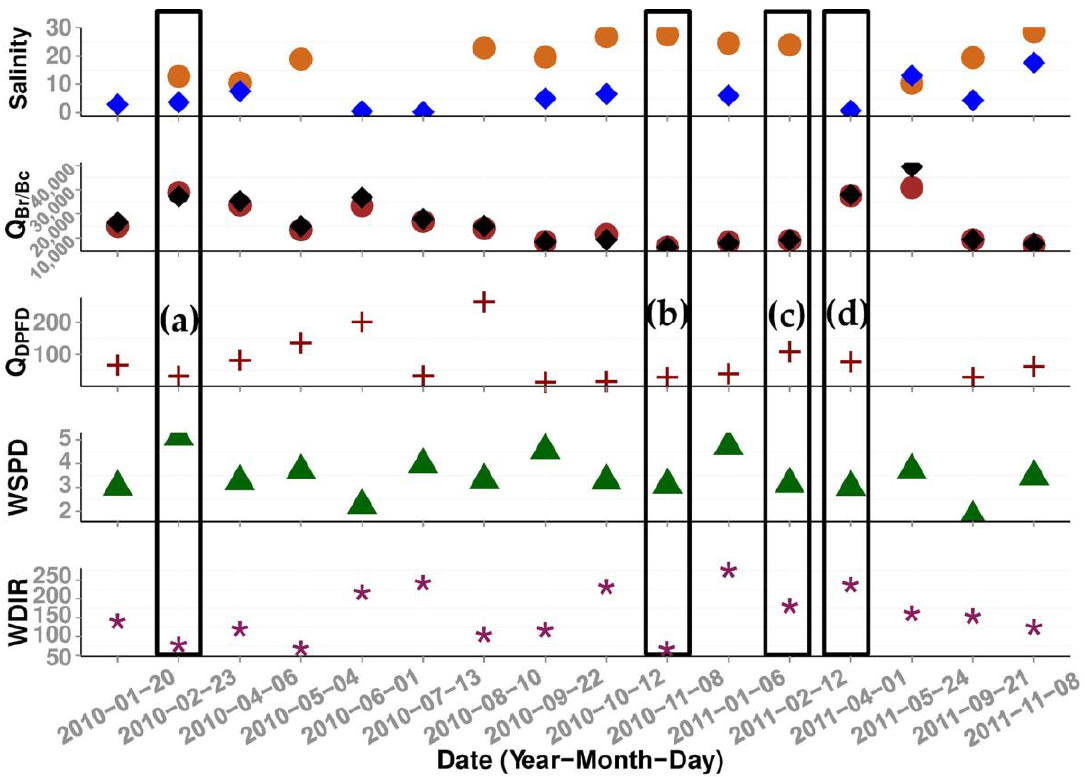
Figure 8. Time-series of salinity (Station 1: dots; Station 15: diamonds), the Mississippi river discharge at Baton Rouge (Q BR : diamonds) and Belle Chasse (Q BC : dots) (m 3 /s), discharge at Davis Pond Freshwater Diversion (Q DPFD ) (m 3 ∙s −1 ), wind speed (m/s) and wind direction (degrees from north) corresponding to monthly-observed a g 355 (m −1 ) in Barataria Bay in 2010 and 2011. The boxes ( a – d ) represent the meteorological and hydrological conditions corresponding to the CDOM maps illustrated in Figure